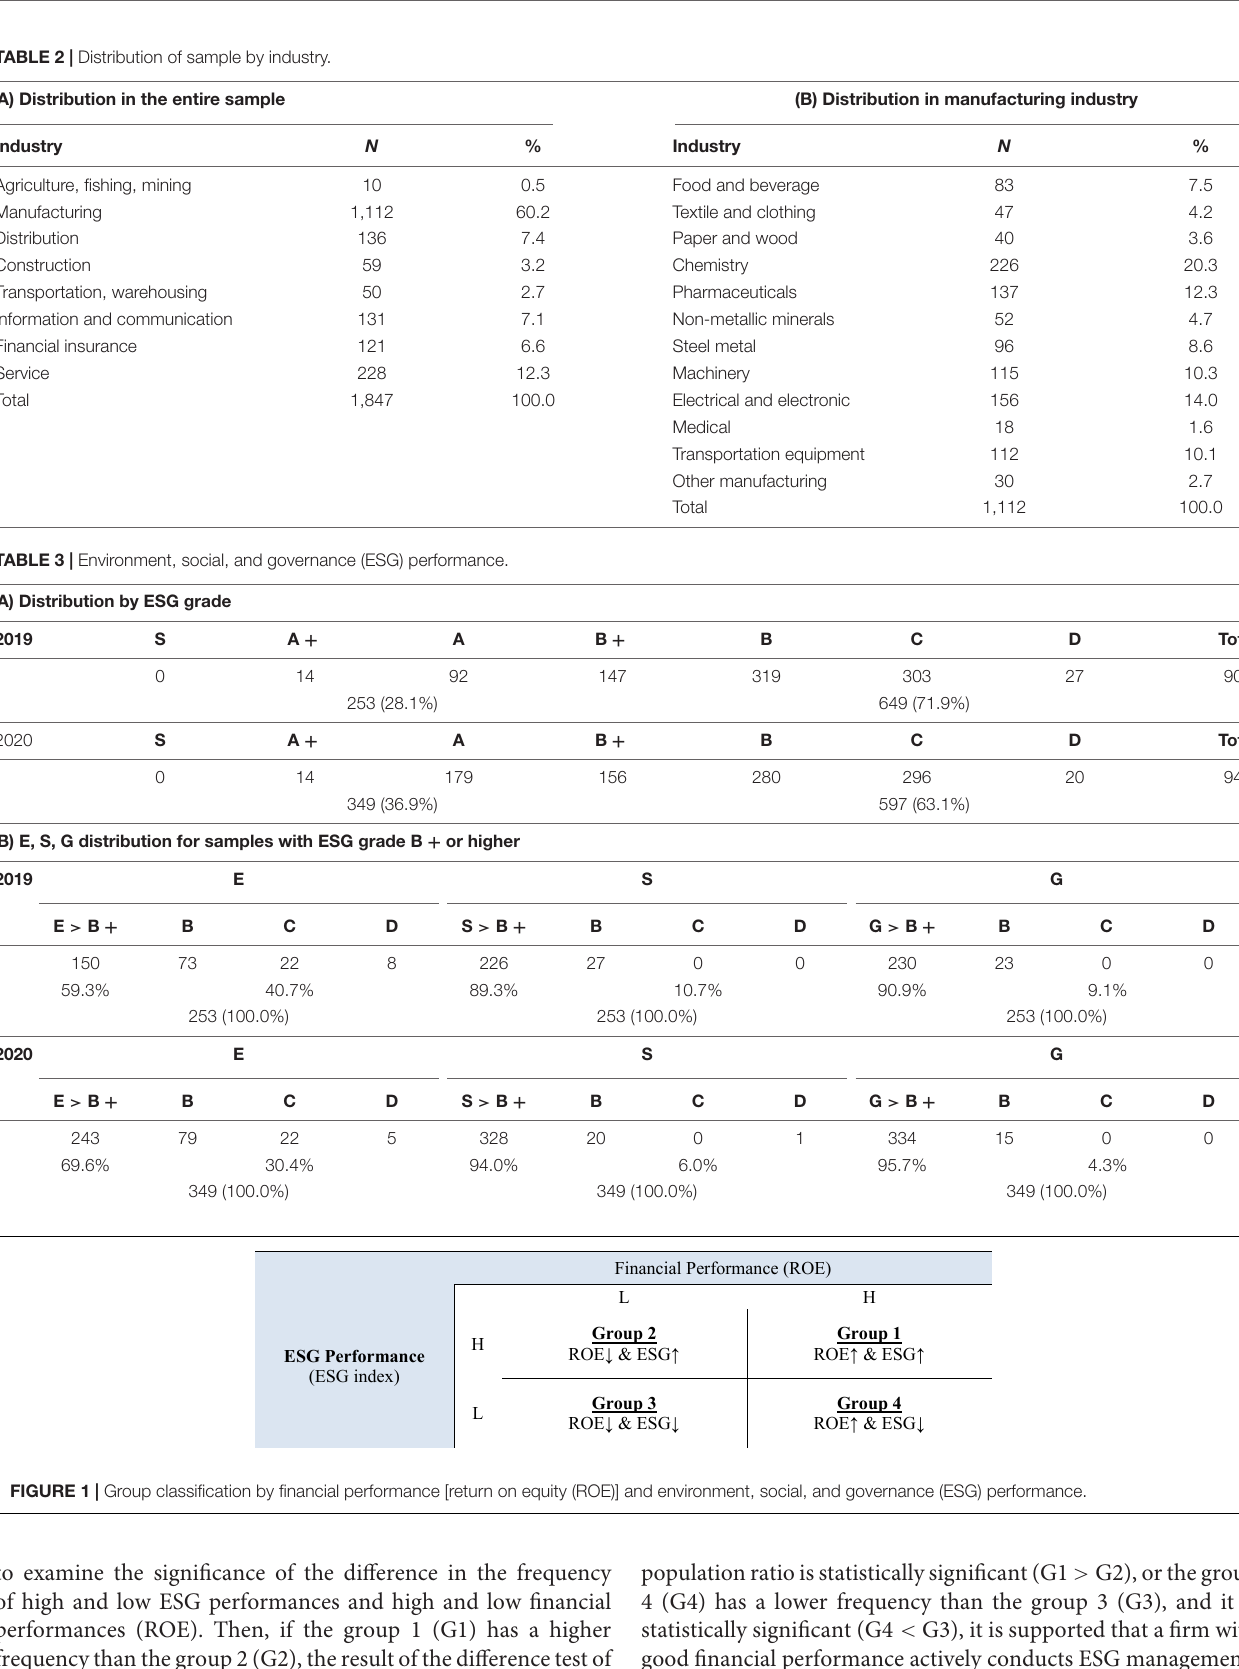
to examine the significance of the difference in the frequency of high and low ESG performances and high and low financial performances (ROE). Then, if the group 1 (G1) has a higher frequency than the group 2 (G2), the result of the difference test of